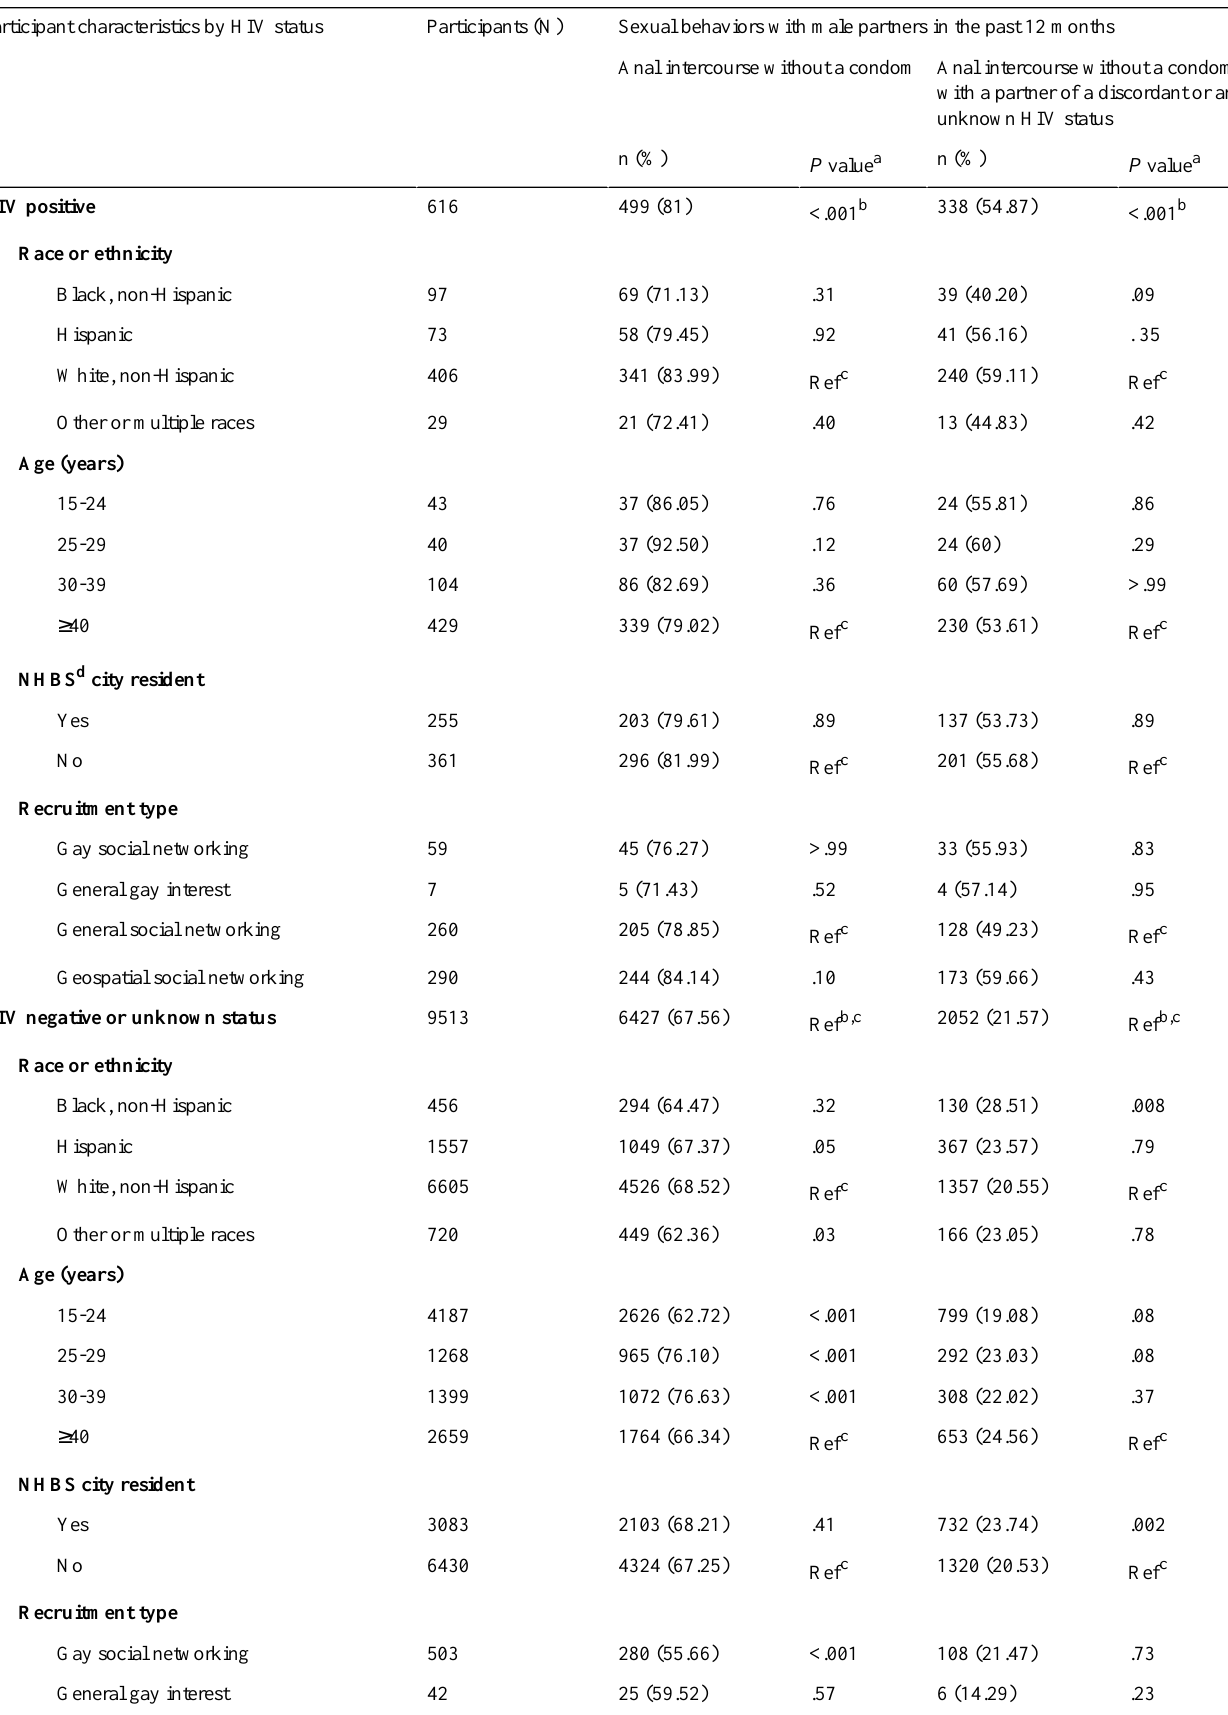
Table 3. Sexual behaviors with male partners of men who have sex with men in the American Men’s Internet Survey, United States,